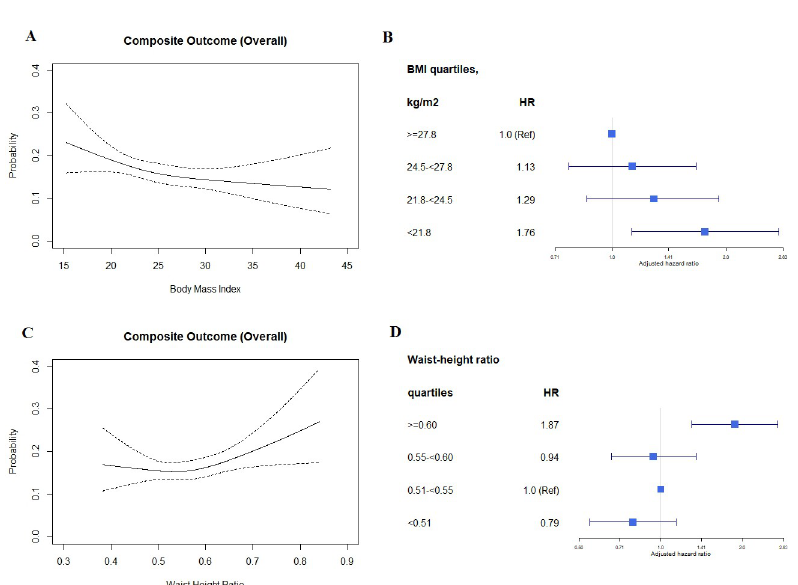
Fig 3. Association of BMI and waist-to-height ratio with the composite outcome using cubic spline regression models and Cox proportional hazards models. Cubic spline regression models (A and C); Cox proportional hazards models (B and D). HR, hazard